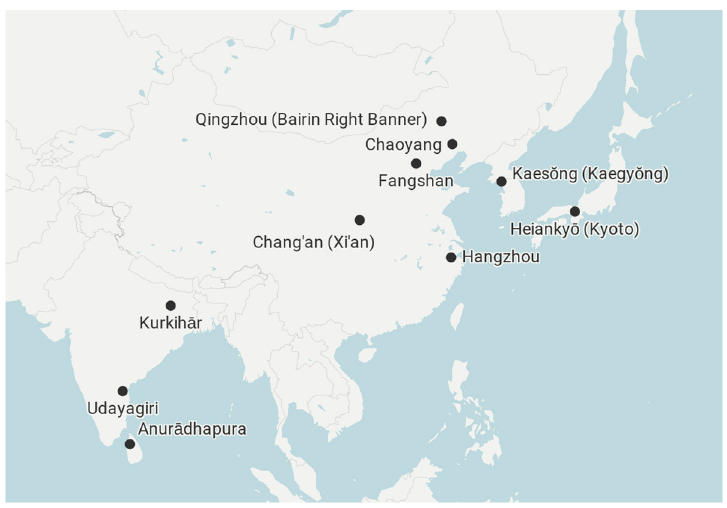
Figure 1. Major sites in the transfer and practice of the Kara ṇḍ amudr ā Dh ā ra ṇ ī , eighth–twelfth century.